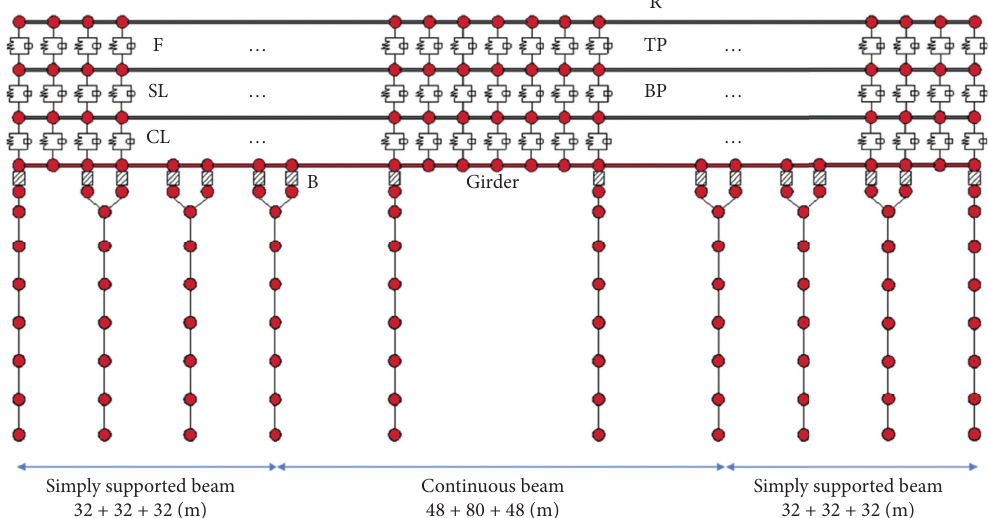
Figure 8: Elevation view of modeling scheme for HSRB prototype (R: rail, F: fasten, TP: track plate, BP: base plate, SL: slide layer, B: bearing, and CL: CA